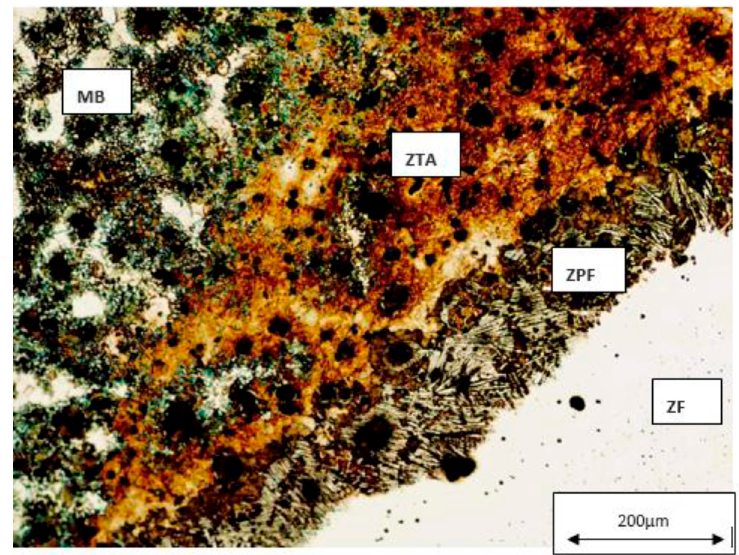
Figure 11. Metallographic analysis of the 2P0W2P0 sample, with 4% Nital and 200× magnification. Table 3. Best mechanical results obtained in study